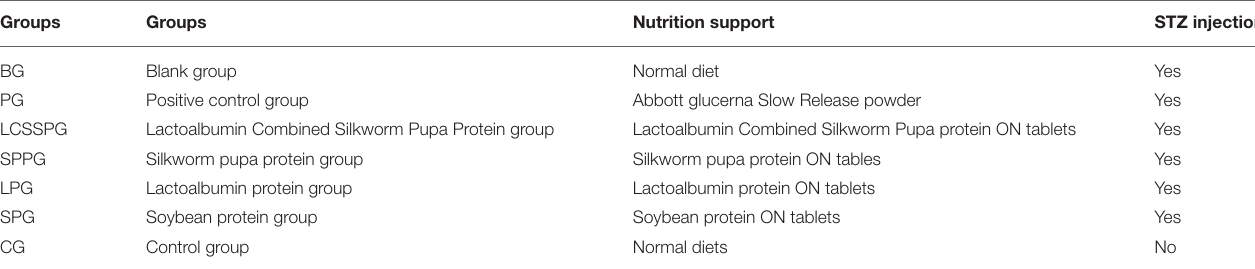
TABLE 3 | Information’s about the seven groups.